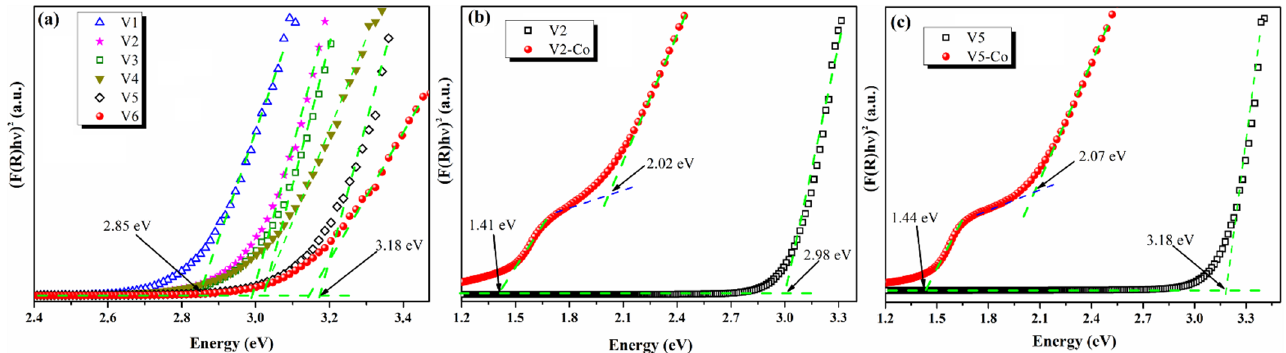
Figure 9. The Kubelka–Munk plots of different CeO 2 NPs samples: V1–V6 ( a ), V2-Co comparative to V2 ( b ), and V5-Co relative to V5 ( c ).